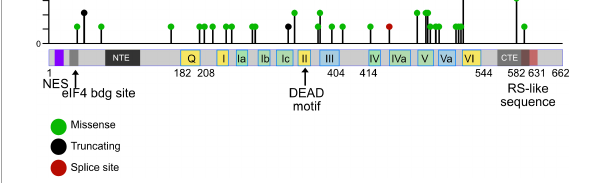
FIGURE 4 Mutations in the human DDX3X gene. Lollipop plot showing mutations in the DDX3X gene in DLBCL that were identi fi ed using cancer- associated genomic database from cBioPortal as an example. The distribution of mutations extends over almost the entire coding region and includes missense and nonsense mutations as well as mutations that introduce splice site errors or truncations,